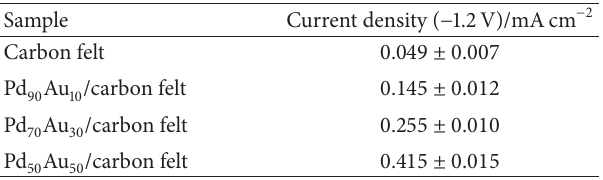
Table1:Currentdensity(mAcm − 2 )forhydrogenevolutionreaction (HER) for investigated electrodes in 67 mMPBS (pH